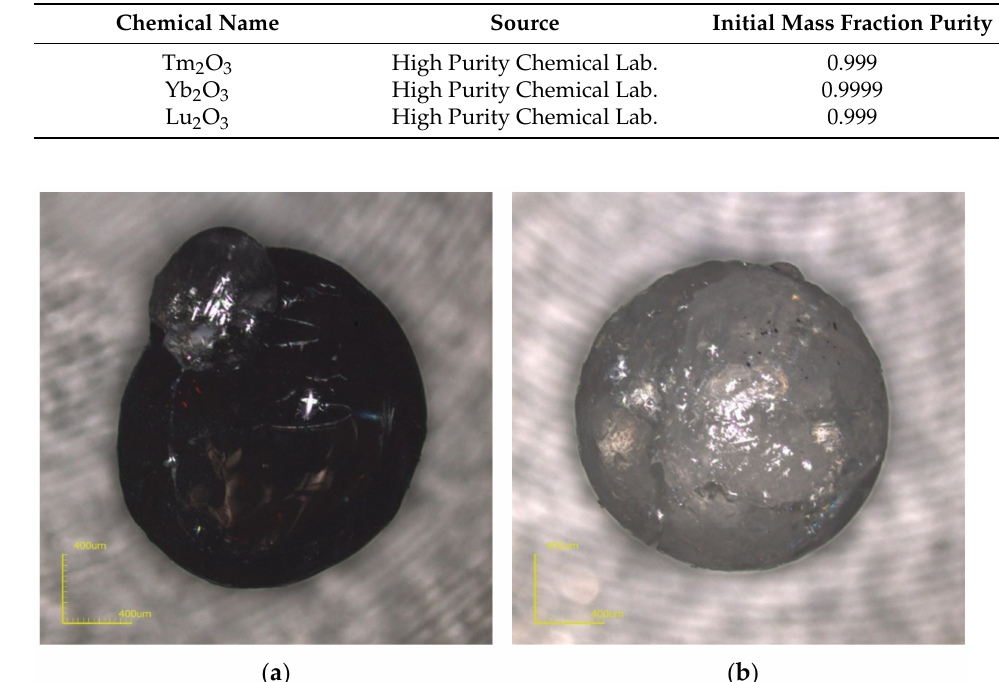
Figure 3. A Yb 2 O 3 sample used for the experiment in the ISS-ELF: ( a ) before flight; ( b ) after flight. Among 10 samples, 5 samples were selected for each specimen, weighed, inserted in a sample holder, and sent to the